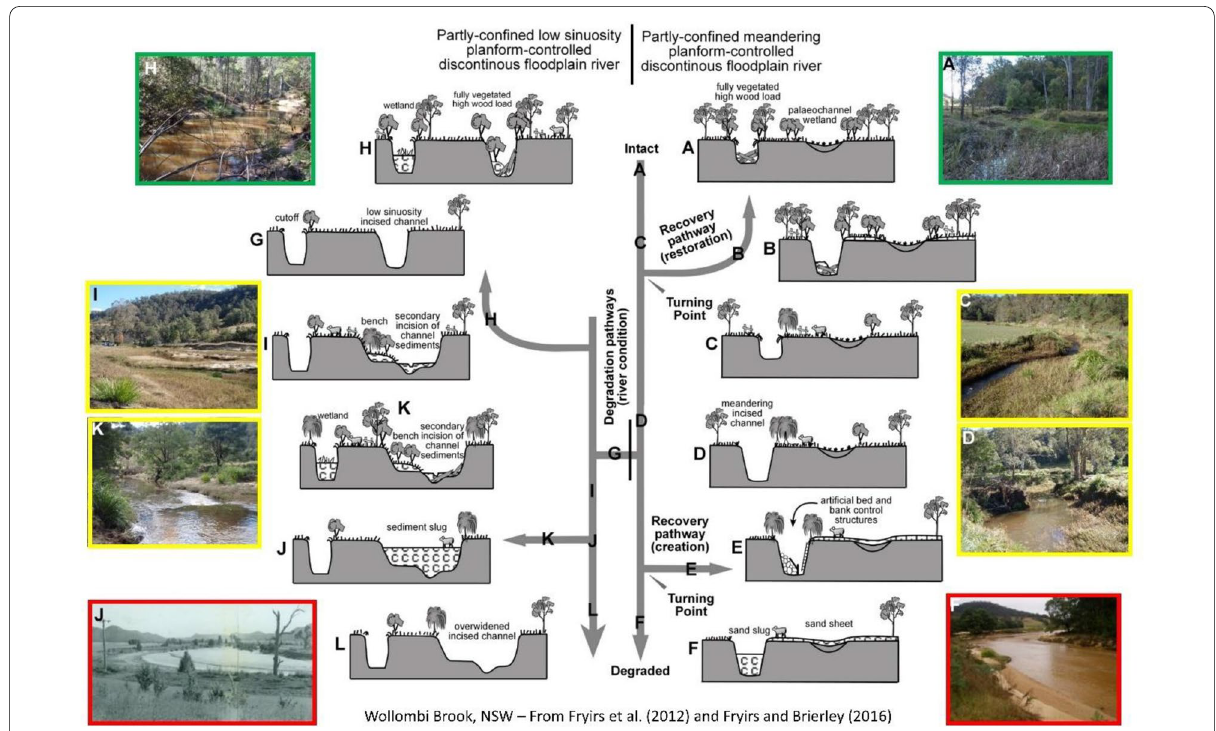
Fig. 6 River recovery diagram. This schematic conceptualisation situates the contemporary state/condition of a river in relation to its evolutionary trajectory (Brierley and Fryirs 2005; Fryirs and Brierley 2016). The vertical axis reflects deterioration in condition from top to bottom (i.e., from state A to D to F). Lateral axes reflect transition from degradation to recovery. If a reach has not moved far from its intact (best condition) state, restoration is possible (state B). If restoration back to the initial state is no longer possible, but river condition is improving (i.e., recovery is evident), the reach lies on a creation pathway (state E). The left hand side summarises responses if irreversible river change occurs (in this instance from a meandering to a low sinuosity partly confined river). Continued degradation is envisaged in states I, J and L, whereas state H shows recovery along a restoration pathway for this new type of river and state K shows recovery along a creation pathway. Green boxes are reaches in good geomorphic condition, yellow in moderate and red are in poor geomorphic condition (see Truth 3